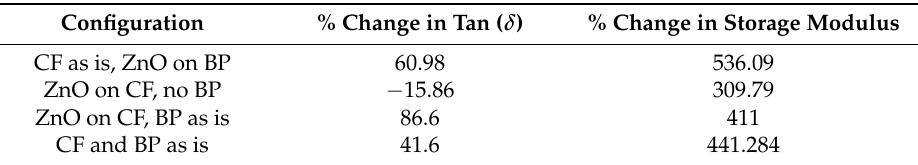
Table 2. Percentage change of tan delta (at 75 ◦ C) and storage modules (at 60 ◦ C) in thermal DMA scan at 30 ◦ C and 1.0 Hz with respect to the composite based on CF